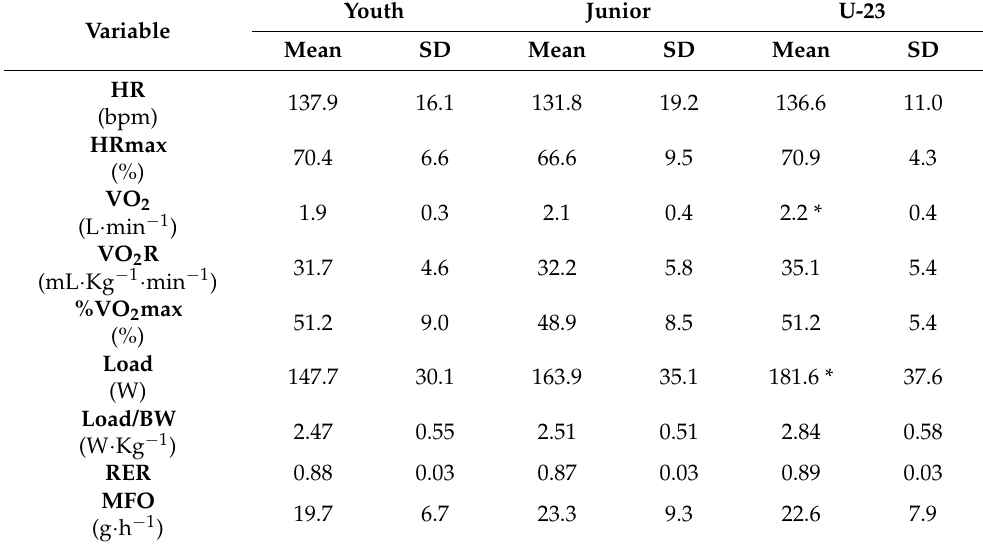
Table 4. Values in the maximal fat oxidation zone.